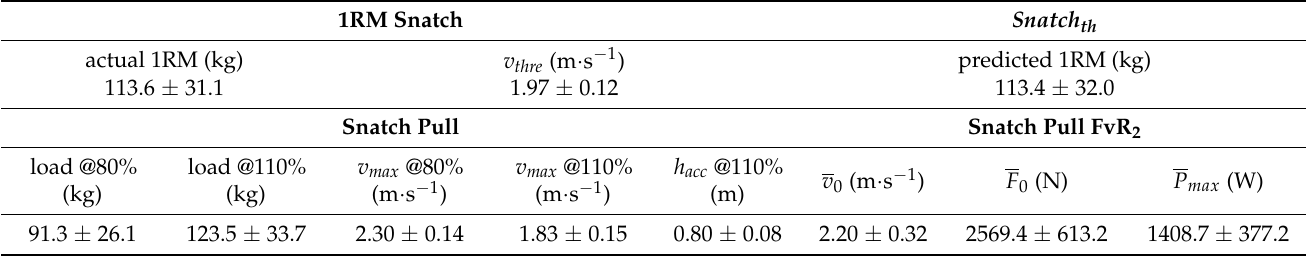
Table 2. Descriptive data in means and standard deviations for the actual 1RM snatch, snatch th , snatch pull, and snatch pull FvR 2 . 1RM Snatch Snatch th actual 1RM (kg) v thre (m · s − 1 )